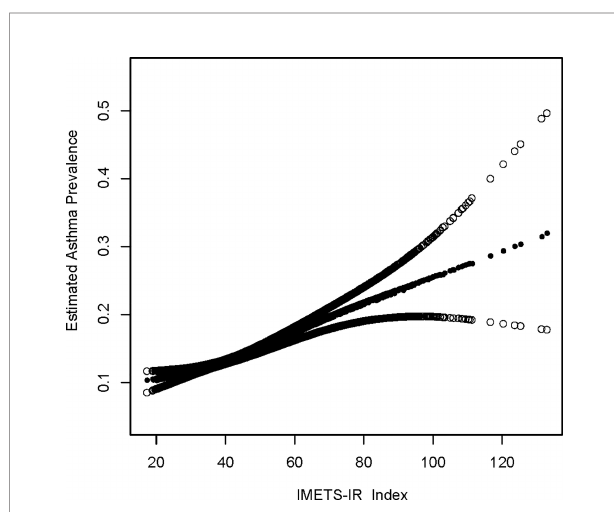
FIGURE 1 | Density dose-response relationship between METS-IR index with asthma prevalence. The area between the upper and lower dashed lines is represented as 95% CI. Each point shows the magnitude of the METS-IR index and is connected to form a continuous line. Adjusted for all covariates except effect modi fi